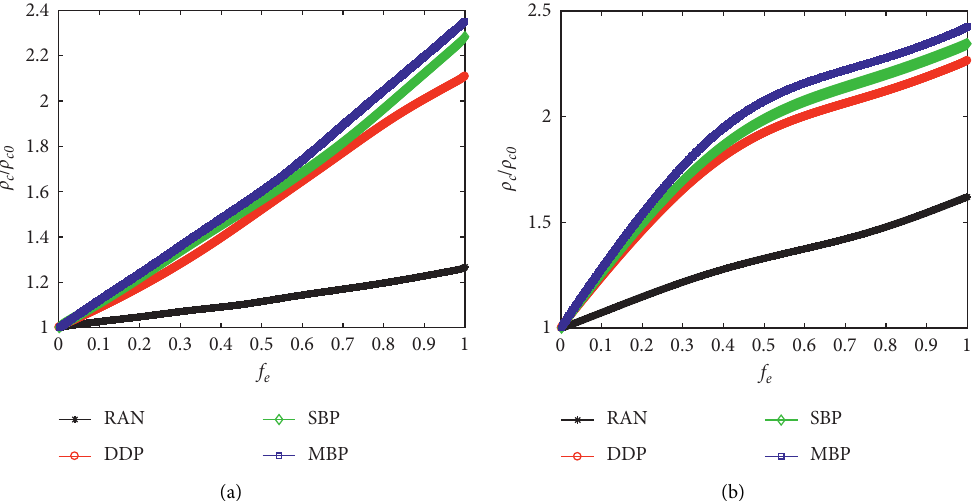
Figure 2: The enhancement of our strategies in multiplex network: (N) � 128, (m) � 4, < (k) > � 16, and (Z) and (b) (Z) in �